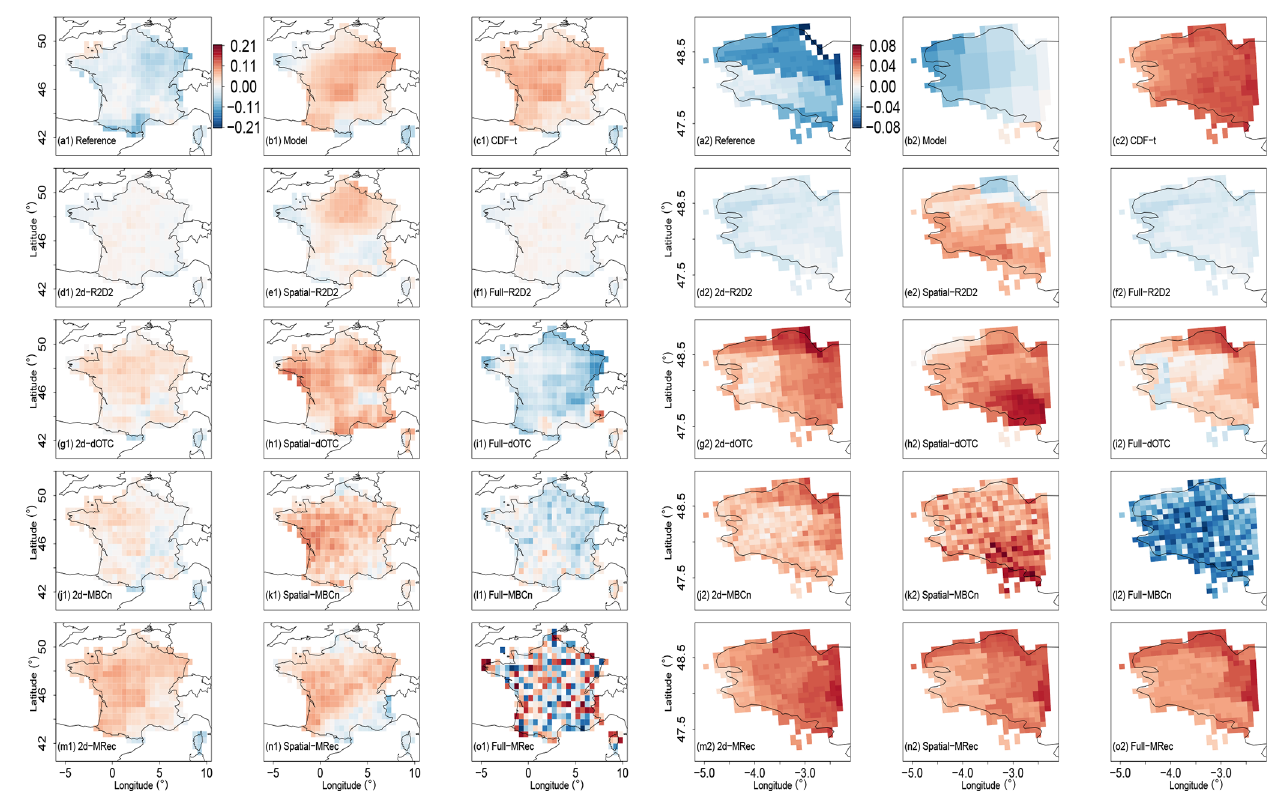
Figure 6. Differences of temperature vs. precipitation Spearman correlations computed at each grid cell between the 1979–1997 and 1998– 2016 periods during winter. (a1–o1) WFDEI and (a2–o2) SAFRAN data are used as references for the bias correction. Note that the color scales between panels (a1) – (o1) and (a2) – (o2) are not the same to better emphasize intensities of values of the two